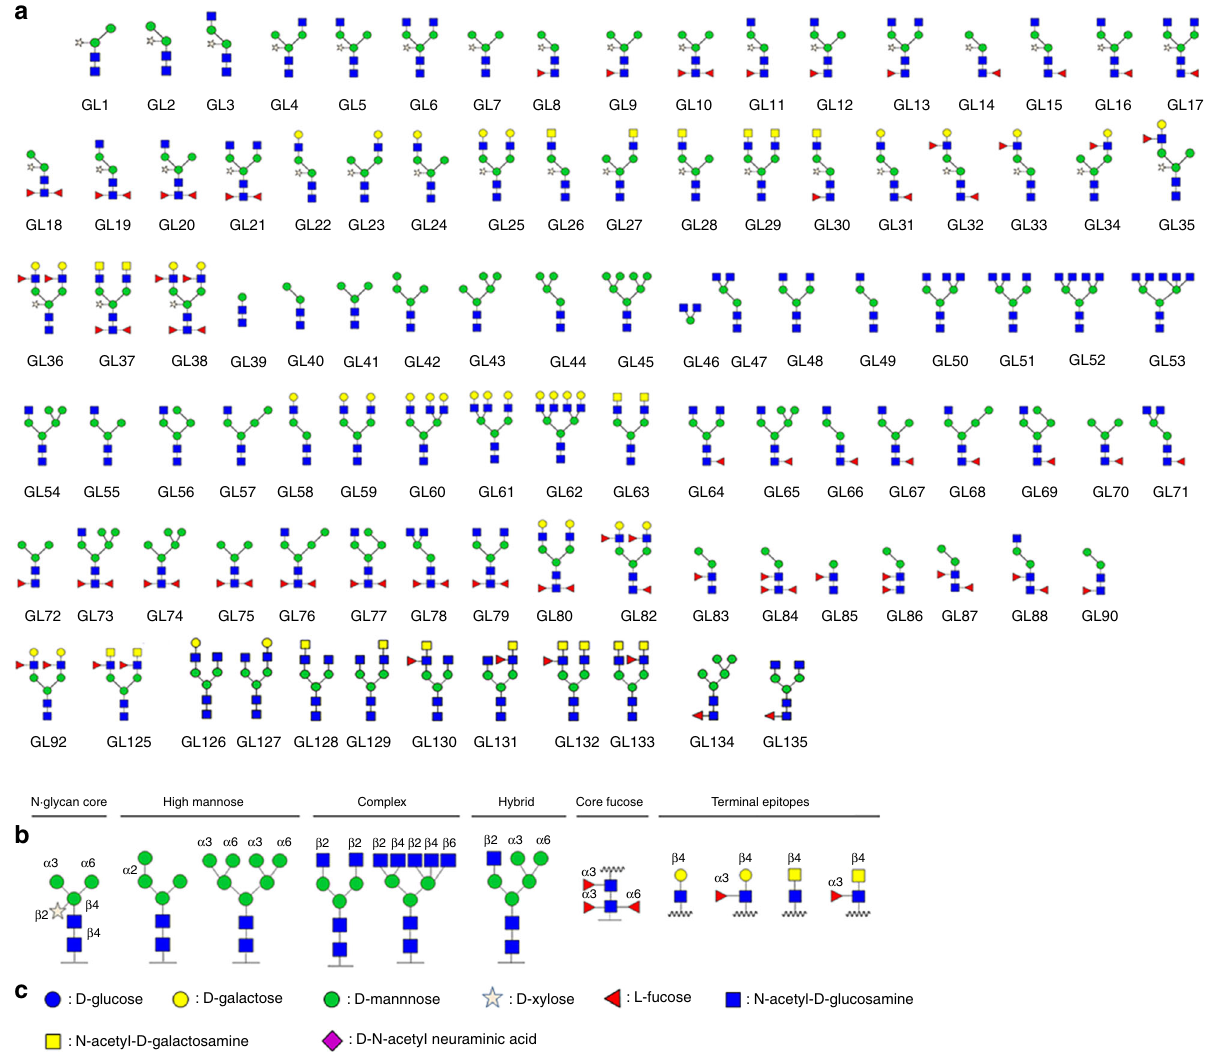
Fig. 1 Glycan microarray employed for assessing Hs FUT8 substrate selectivity. a Pictogram representation of N -glycan structures included on the glycan array. b Speci fi cation of glycosidic bond con fi gurations. c Monosaccharide symbol nomenclature according to Consortium of Functional Glycomics recommendations. See the following link for further information,